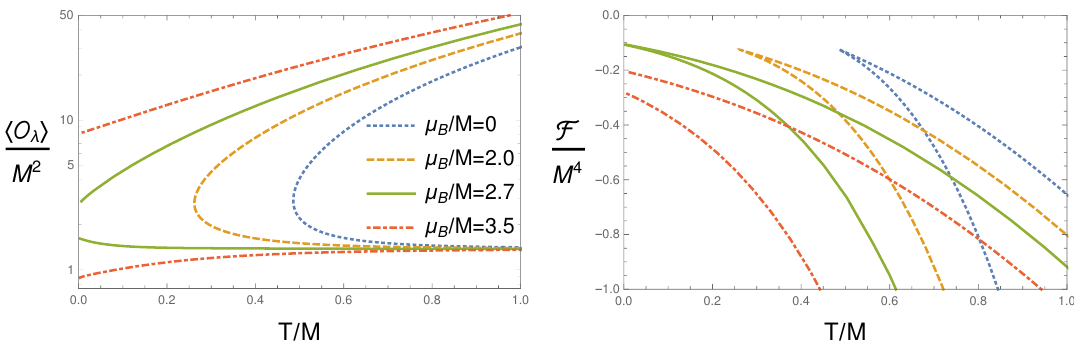
Figure 3 . Expectation value of the operator dual to (cid:21) (Left panel; note the logarithmic vertical axis) and the free energy (Right panel) as functions of the temperature, at various chemical poten- tials. The branch of solutions with lower expectation value on the left corresponds to the one with lower free energy on the right, and is thus dominant. As the orange region in (cid:12)gure 2 is approached, the two branches